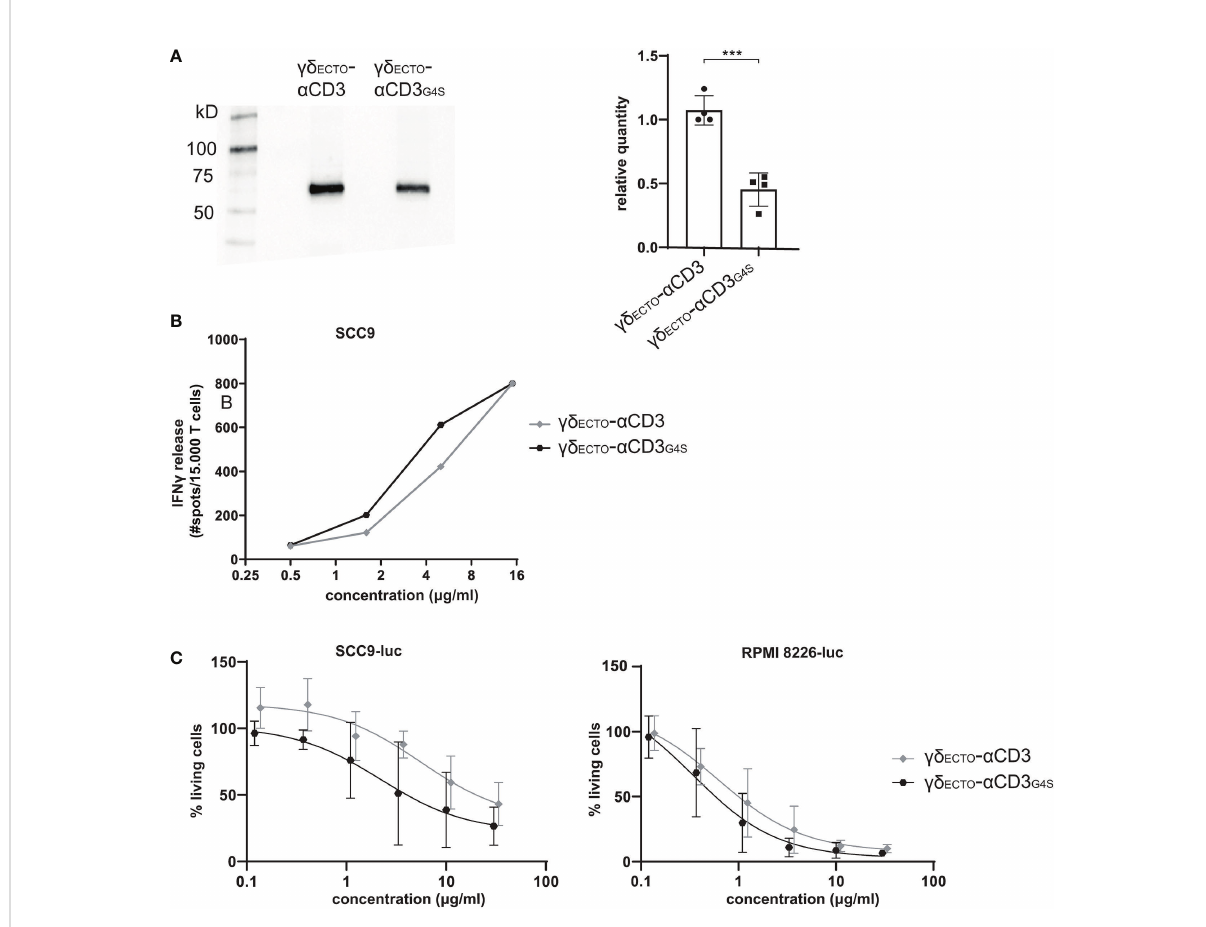
FIGURE 5 Functionality and expression of gd ecto - a CD3 and gd ecto - a CD3 G4S . (A) Westernblot of unpuri fi ed expression medium with gd ecto - a CD3 and gd ecto - a CD3 G4S GAB. The ecto g ecto- a CD3 chain is visualized by a -HIS western blot B) T lymphocytes were co-incubated with SCC9 target cells in the presence of PAM (100 µM) and gd ecto - a CD3 3(G4S)/G4S (0.5-15 µg/ml) overnight. IFNy was measured by ELISPOT C) Effector and luciferase transduced RPMI 8226 were co-incubated for 16 hours in the presence and absence of gd ecto - a CD3 3(G4S)/G4S at different concentrations and PAM (30 m M). Percentage viable cells was determined by comparing luminescence signal to the no gd ecto - a CD3 condition, representing 100% viability. N=4 (A) , N=2 (B) , N=4 (C) , error bars represent SD. Signi fi cance was calculated using an unpaired T-test ***P ≤